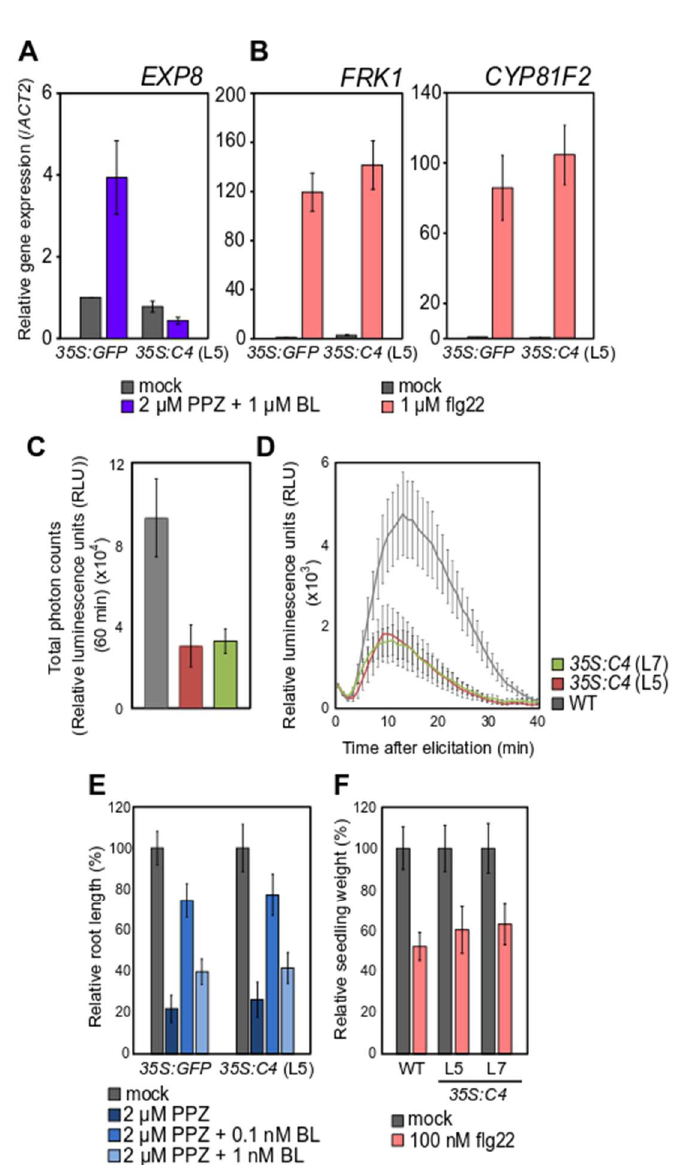
Figure 4. C4 a ff ects some, but not all, BRI1 and FLS2 downstream readouts. Relative expression of the BL responsive gene EXP8 ( A ) or of the flg22 responsive genes FRK1 and CYP8IF2 ( B ). Bars represent mean expression in 10-day-old T3 35S:GFP and T2 35S:C4 (L5) transgenic Arabidopsis seedlings treated with 1 µ M epiBL ( A ) or 1 µ M flg22 ( B ) one hour prior sample harvesting ± SD, n = 3 (technical replicates), as measured by quantitative real-time-polymerase chain reaction (qRT-PCR). Three independent biological replicates were performed, and results from one representative replicate are shown. ( C , D ) Production of reactive oxygen species (ROS) in four-week-old wild-type (WT) and T3 35S:C4 transgenic Arabidopsis (L5, L7) plants upon 100 nM flg22 treatment measured as total photon counts during 60 min ( C ) (bars represent averages values ± SE, n = 12) or as relative luminescence units (RLU) along 40 min ( D ). Three independent biological replicates were performed; values correspond to one representative replicate ± SE, n = 12 (leaf discs from independent leaves). ( E ) Normalized root length of 12-day-old T3 35S:GFP and T2 35S:C4 (L5) transgenic Arabidopsis seedlings following depletion of (2 µ M Propiconazol (PPZ)) and exogenous addition of brassinosteroids (0.1 and 1 nM epiBL) for six days, ± SD, n = 12–16. Three independent biological replicates were performed with similar results; results from one replicate are shown. ( F ) Relative seedling growth inhibition of 10-day-old WT and T3 35S:C4 transgenic Arabidopsis (L7, L5) seedlings upon 100 nM flg22 treatment ± SE, n = 14–16. Three independent biological replicates were performed with similar results; results from one replicate are